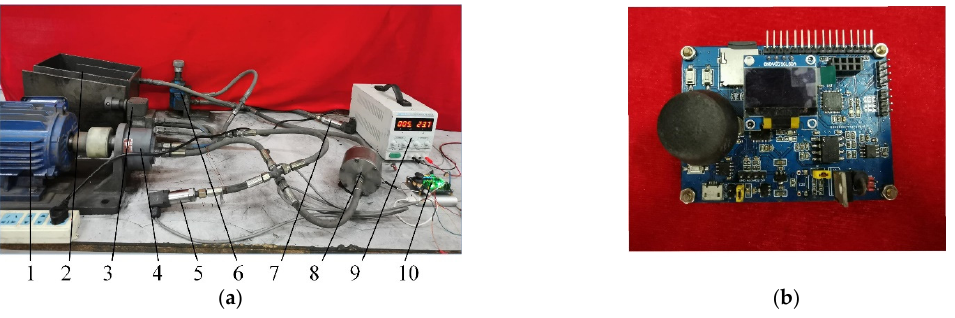
Figure 15. Experimental test rig of the enhanced radial MR valve: ( a ) performance test system, ( b ) data acquisition device. 1. Motor, 2. MR fluid tank, 3. Relief valve (A), 4. Gear pump, 5. Pressure sensor ( a ), 6. Relief valve (B), 7. Pressure sensor ( b ), 8. MR valve, 9. DC power supply, 10. Data acquisition device.